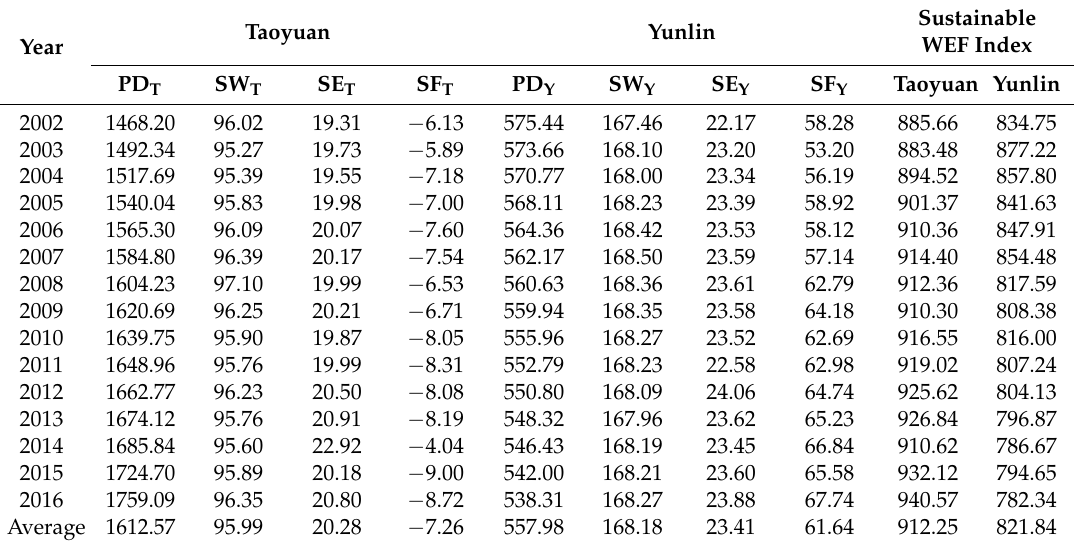
Table 4. Results of the sustainable WEF